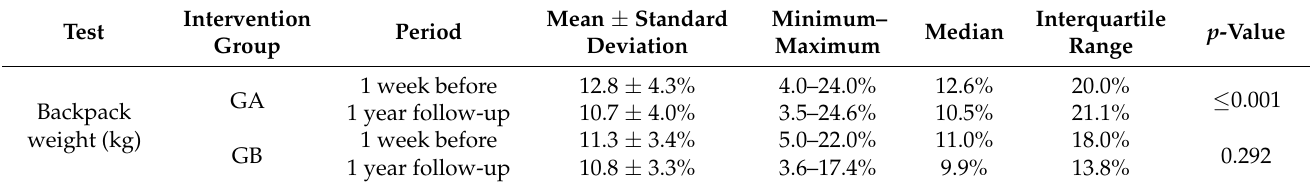
Table 4. Values of backpack weight before and after intervention by groups.